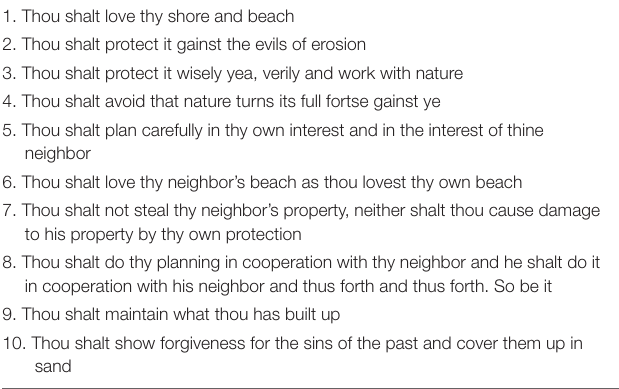
TABLE 1 | The ten demands for coastal protection (Bruun,